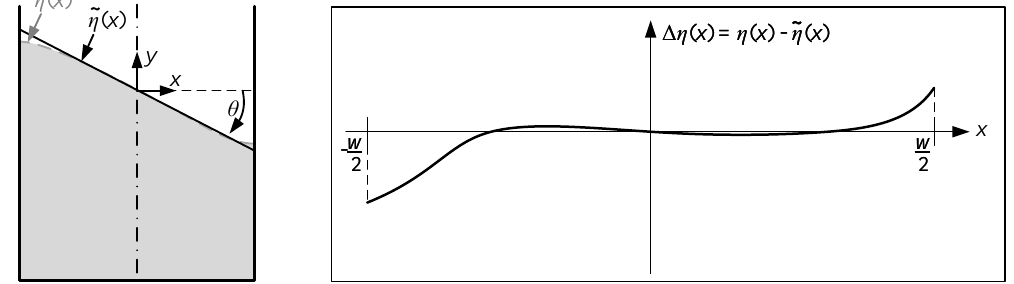
Figure 6. Results of investigating the linearity of the detected fluid